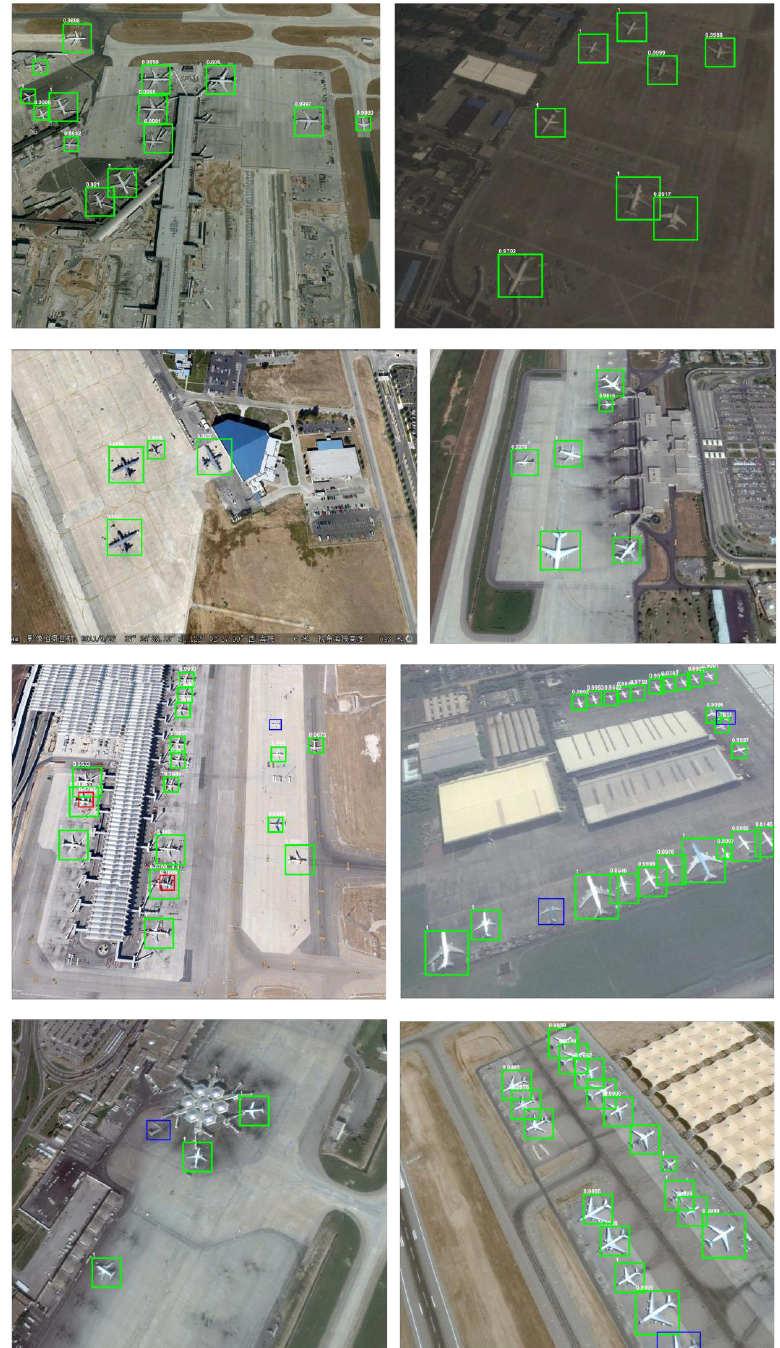
Figure 11. Some visual detection results of the proposed method in the RSOD dataset.